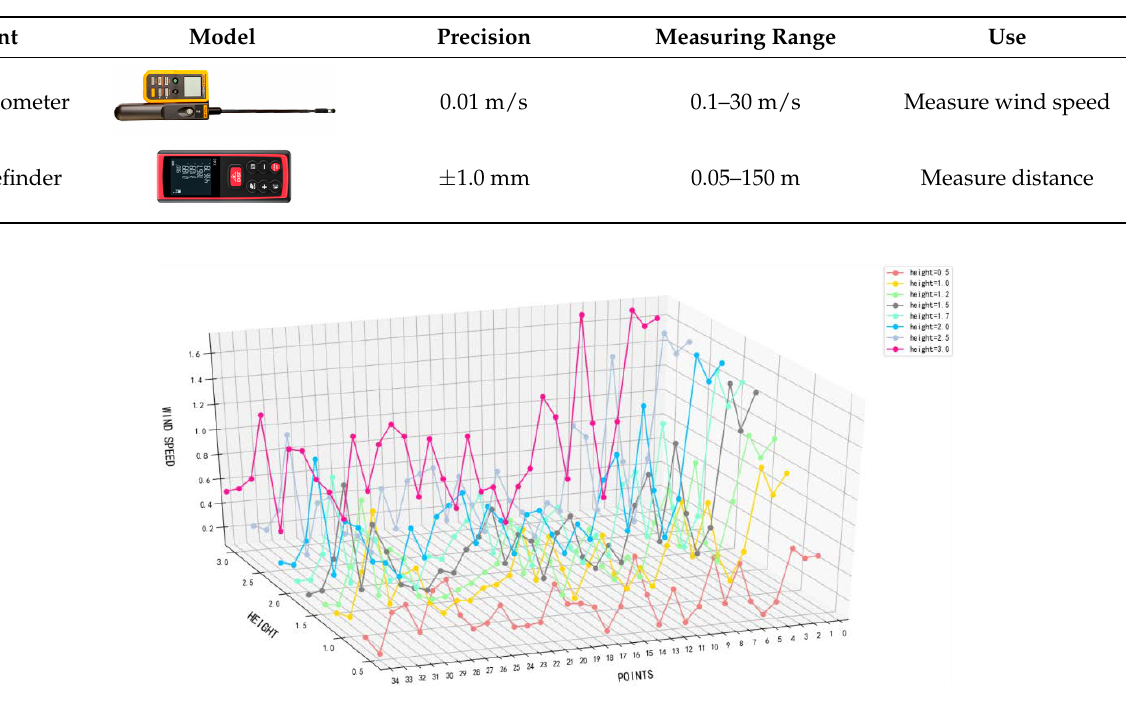
Figure 2. Measured wind speed values at 35 points.